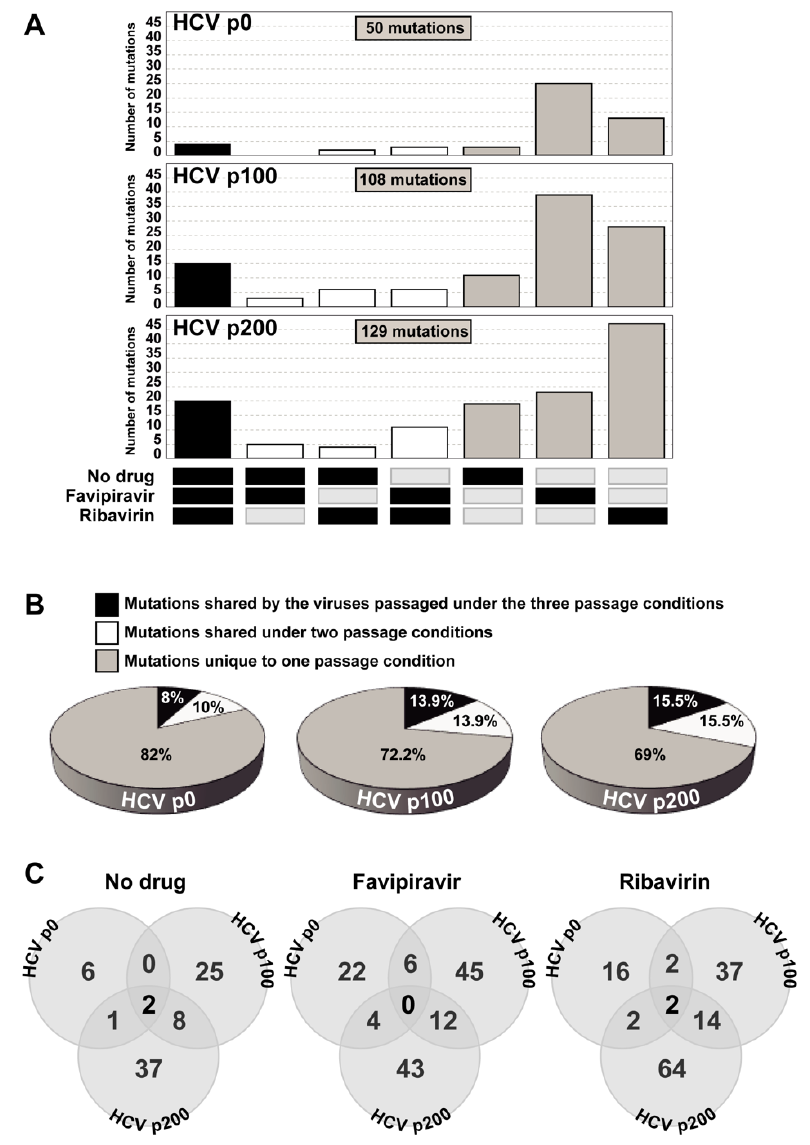
Figure 3. Shared and unique mutations in the hepatitis C virus populations passaged in absence or presence of inhibitors. ( A ) number of mutations (ordinate) that participated in mutational waves in populations derived from HCV p0, HCV p100, and HCV p200 (excluding mutations that appear only in the initial populations), which were shared among conditions of the same virus and also among viruses passaged in the absence or presence of inhibitors; the passage conditions in which mutations were found is indicated by the filled rectangles drawn below the abscissa; note that the majority of mutations was unique to one condition (grey bars). ( B ) summary of the percentage of unique and shared mutations in the populations derived from HCV p0, HCV p100, and HCV p200. The complete list of mutations and deduced amino acid substitutions is given in Tables S3–S5 of [19]. ( C ) Venn diagram of mutations that are shared among HCV p0, HCV p100 and HCV p200 in the three experimental conditions (no drug, favipiravir, and ribavirin). The experimental procedures are described in the text.